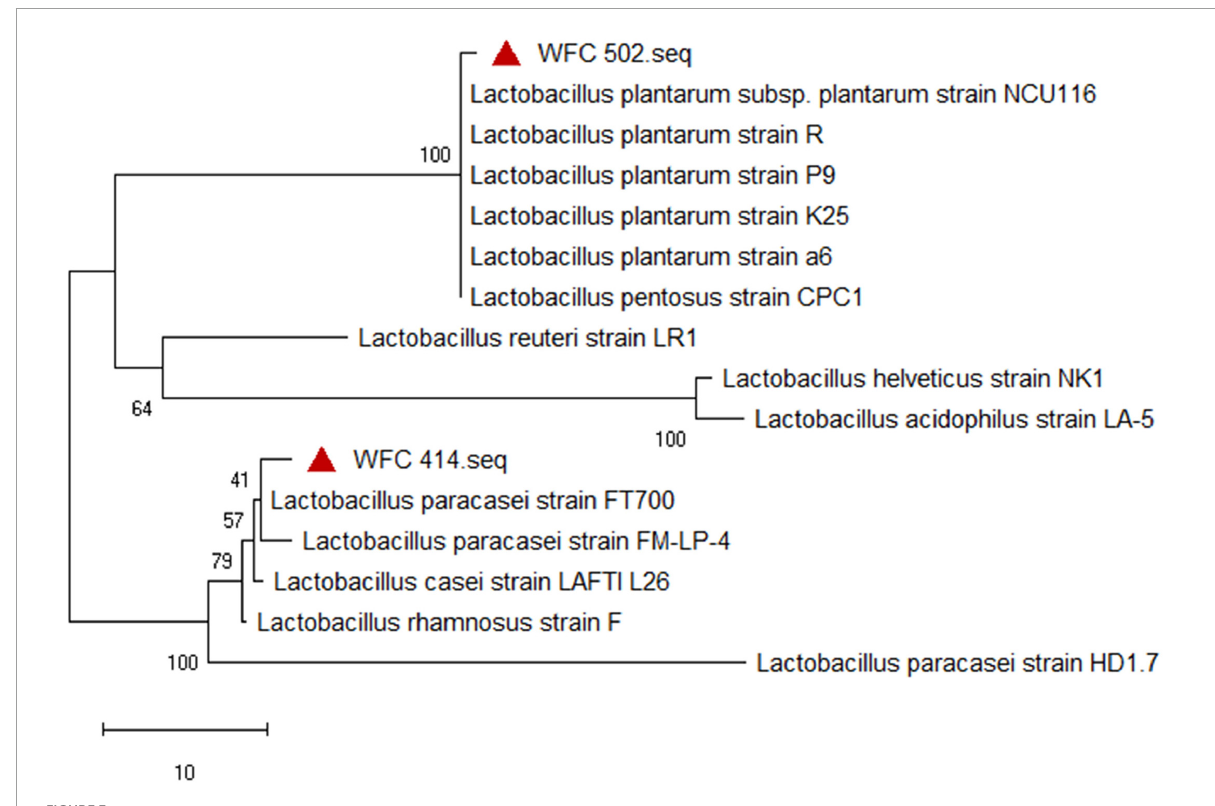
FIGURE3 Position of the WFC 414 and WFC 502 strains in the neighbor joining phylogenetic